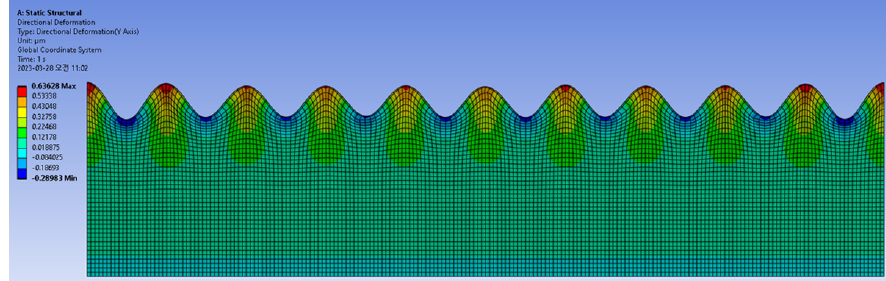
Figure 2. Buckled thin film due to applied strain.